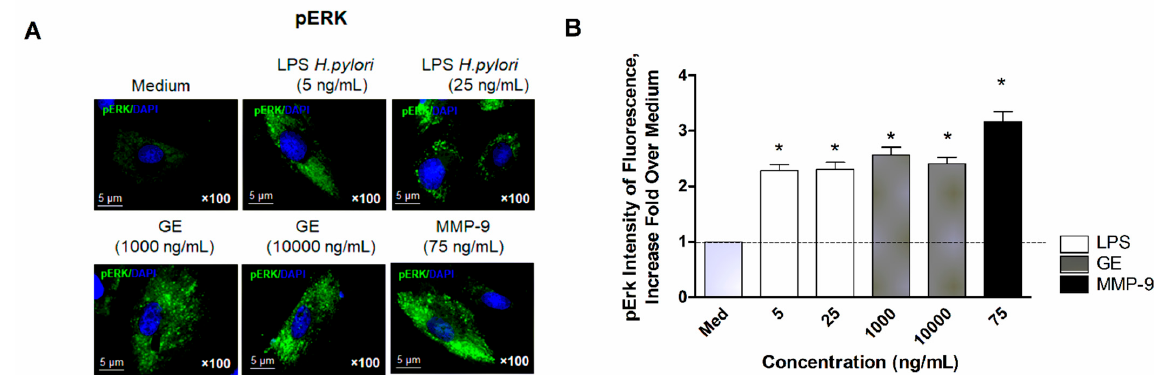
Figure 8. Analysis of ERK activation/phosphorylation (pERK) in vascular endothelial cells. ( A ) Representative pictures of pERK in endothelial cells unstimulated or treated with H. pylori antigenic components: glycine acid extract (GE), lipopolysaccharide (LPS) or metalloproteinase (MMP)-9 analyzed with fluorescent microscopy at magnification 1000 × . ( B ) pERK expression, presented as the intensity of the fluorescence fold increase over the mediums. A minimum of 100 cells were analyzed. Statistical analysis was performed in the nonparametric U Mann-Whitney test with significance for * p < 0.05 obtained for unstimulated cells vs cells treated with stimulators.